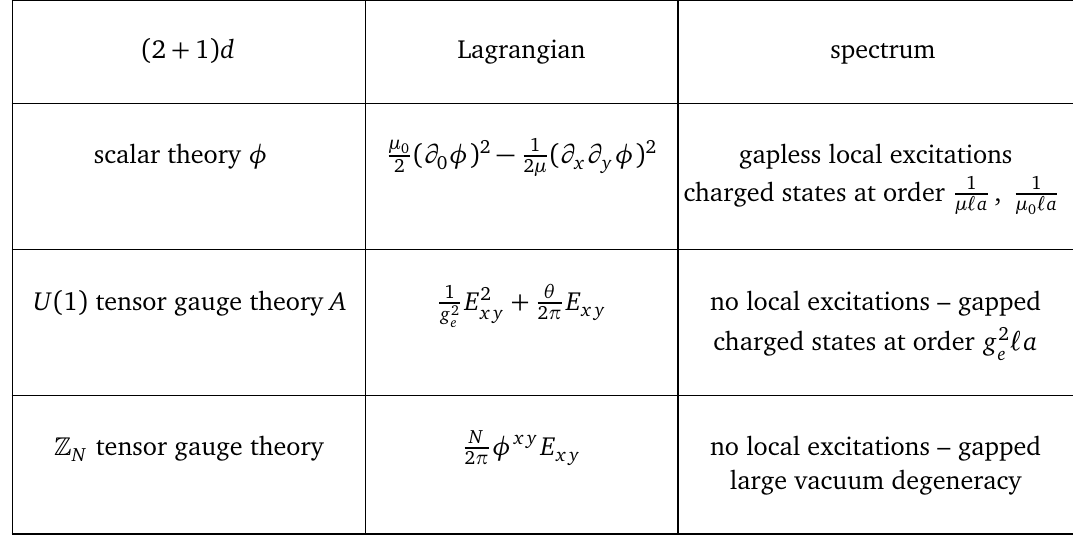
Table 5: Spectra of the continuum field theories discussed in this paper. Depending on the order of limits a → 0 or (cid:96) → ∞ , the energy of the charged states goes to zero or